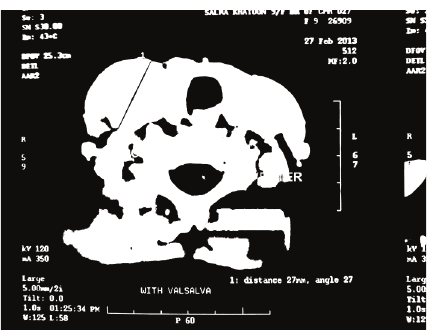
Figure 2: A contrast enhanced CT scan showing ectasia of the right internal jugular